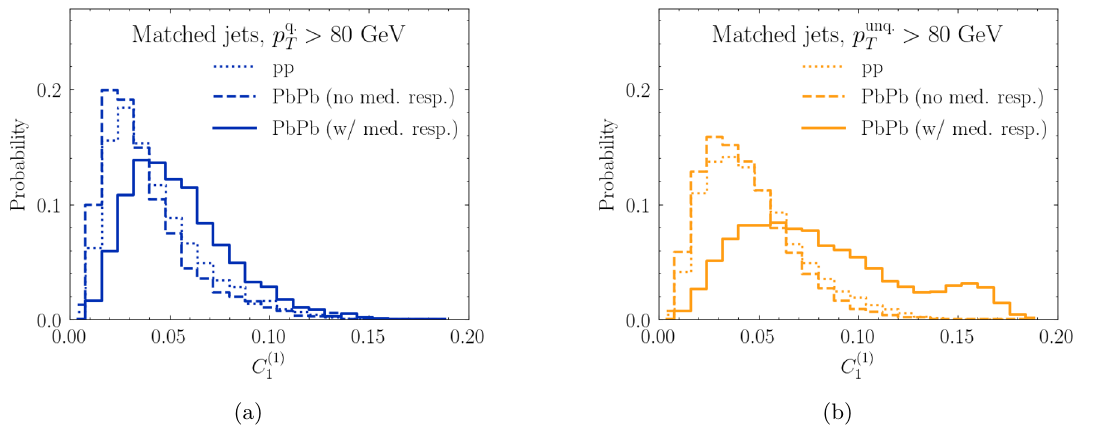
Figure 4. C (1) distributions for jets with quenched p T above 80 GeV (a) and unquenched p T above 1 80 GeV (b), in vacuum (dotted), in heavy ion collisions without medium response (dashed), and in heavy ion collisions with medium response